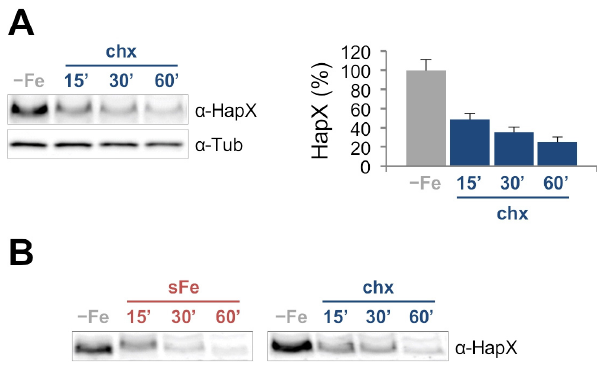
Figure 3. HapX turnover is very fast in − Fe conditions. ( A , B ). HapX quantification by Western blot analysis. Samples were obtained from the wild-type strain grown at 37 ◦ C in AMM − Fe and then supplemented with 50 µ g · mL − 1 cycloheximide (chx) for 15, 30 and 60 min ( A ). Left panel: Representative Western blot analysis showing HapX protein levels. α -Tubulin was used as loading control. Right panel: Densitometric protein quantification. HapX protein levels were normalized to Tubulin and expressed relative to those in − Fe. Barsrepresentstandarddeviationsfromtwoindependent biological experiments with two technical replicates each. ( B ). Comparison of sFe (Figure 1B) and chx (Figure 3A) samples separated in an 7.5% SDS-acrylamide gel for a better band size